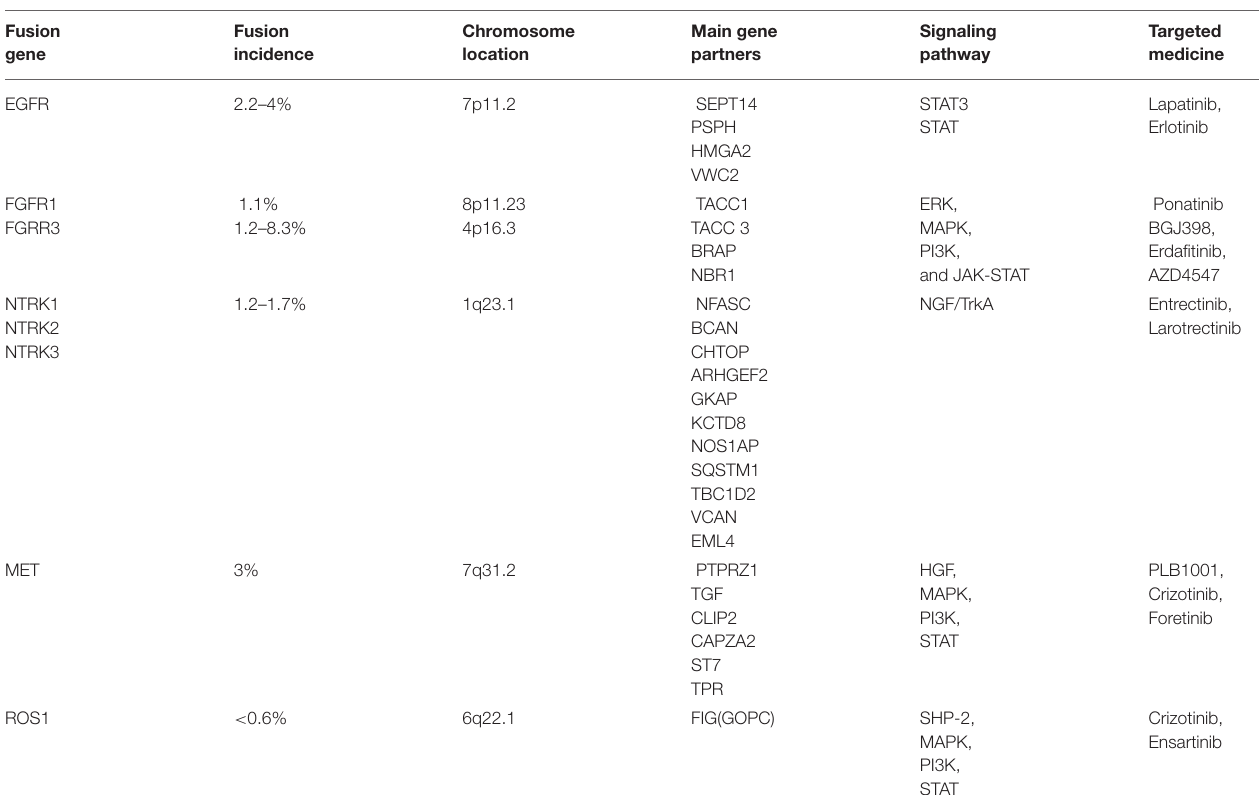
TABLE 2 | Biological characteristics of recurrent gene fusions as therapeutic targets in GBM. Fusion